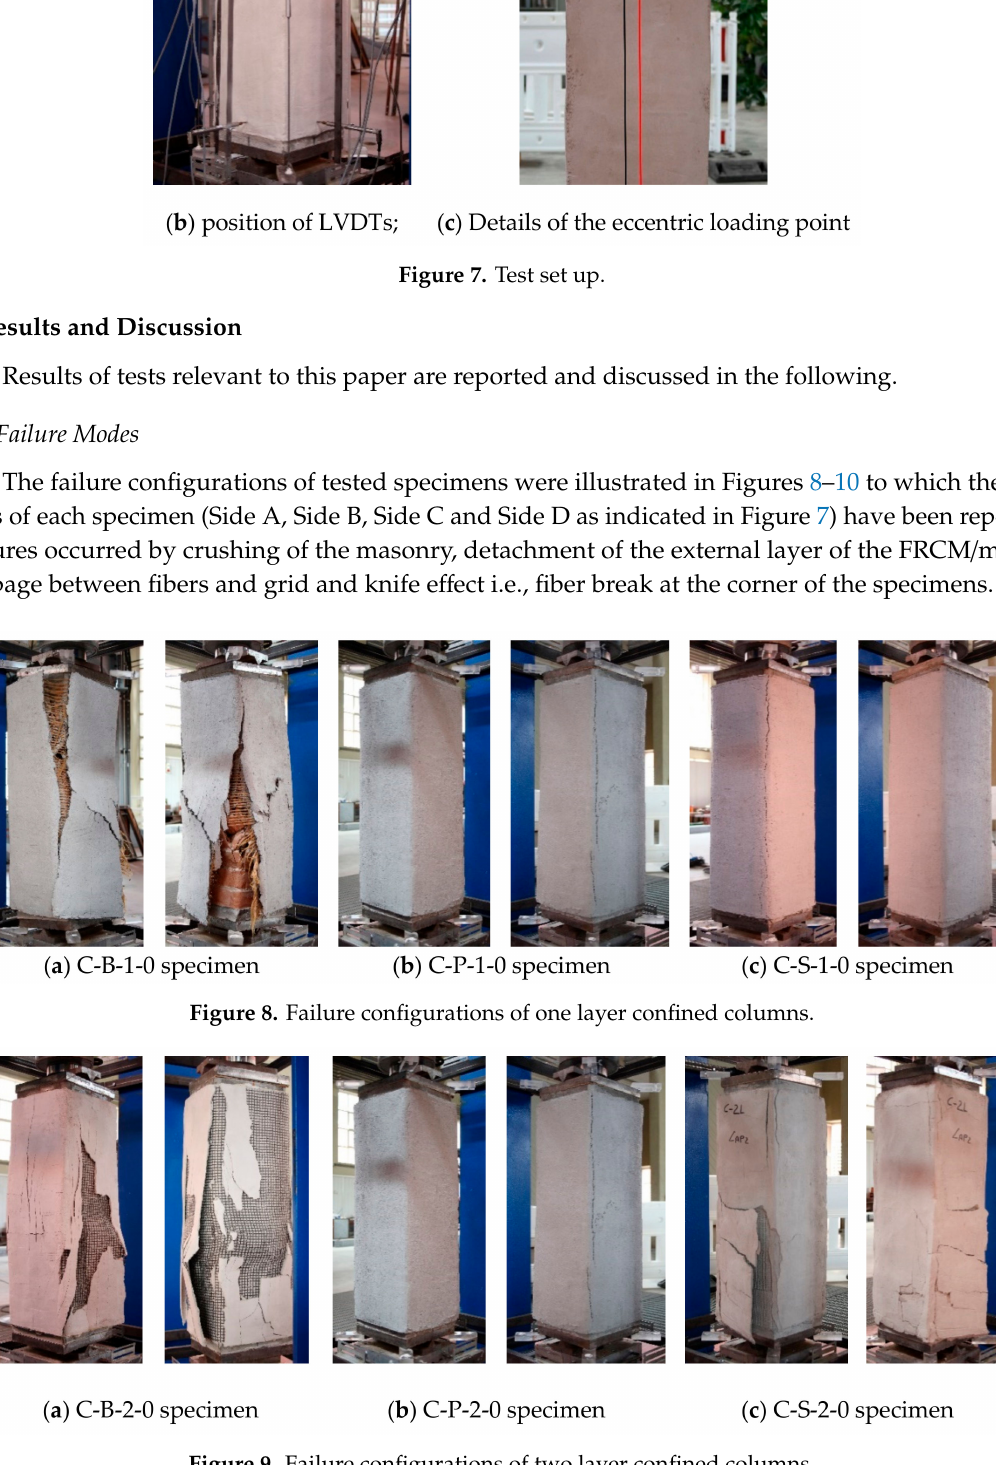
Figure 9. Failure configurations of two layer confined